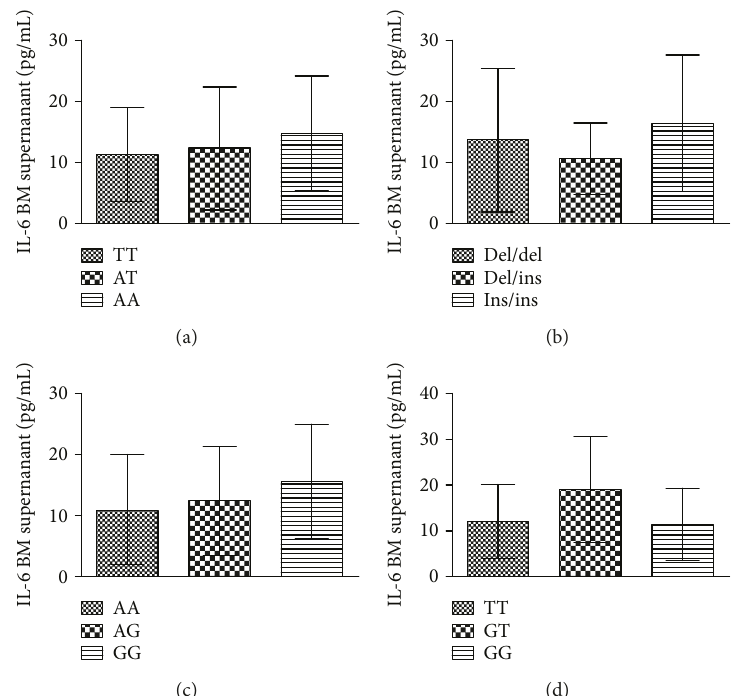
Figure 4: The NLRP3 gene polymorphisms may not a ff ect the IL-6 concentration in the BM supernatant of MM patients. The relationship between the IL-6 expression in the BM supernatant with rs2043211 of CARD8 (a), NF- κ B-94 ins/del ATTG genotypes (b), rs16944 of IL-1 β (c), or rs1946518 of IL-18